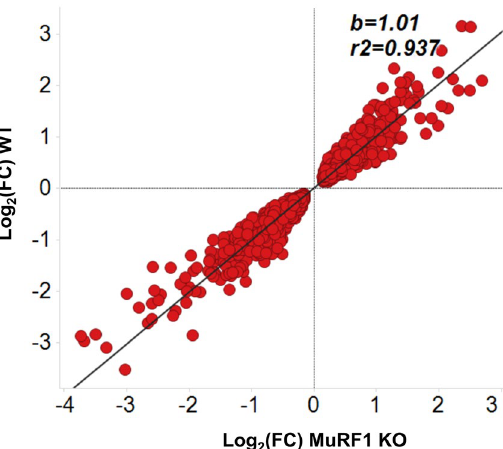
Figure 3. Correlation of soleus gene expression profiles of WT and MuRF1 KO mice exposed to microgravity. With a BH corrected p-value < 0.05 the log 2 (FC) of genes from WT mice were plotted against the log 2 (FC) of genes from MuRF1 KO mice. WT, Wild-type; KO, Knockout; BH, Benjamini–Hochberg; FC,